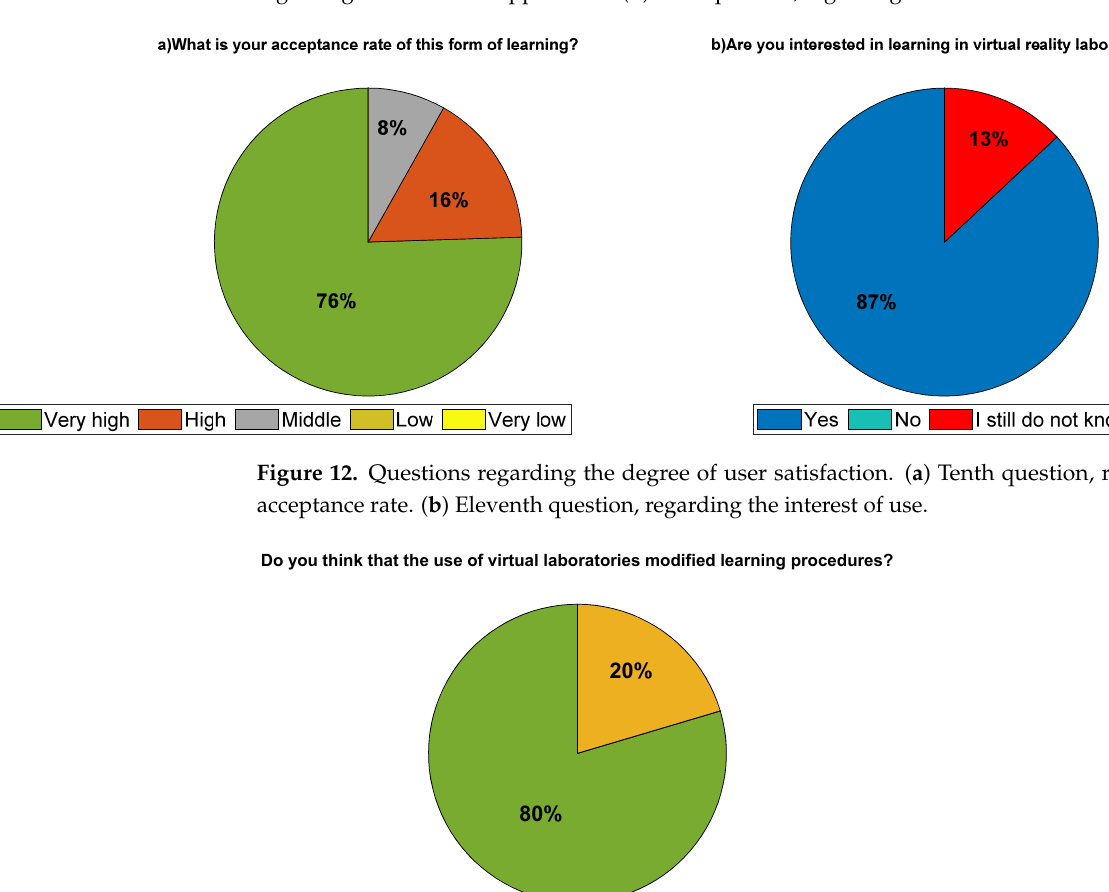
Figure 12. Questions regarding the degree of user satisfaction. ( a ) Tenth question, regarding the acceptance rate. ( b ) Eleventh question, regarding the interest of use. Figure 13. Results of question 14, regarding changes in Figure 13. Results of question 14, regarding changes in learning.